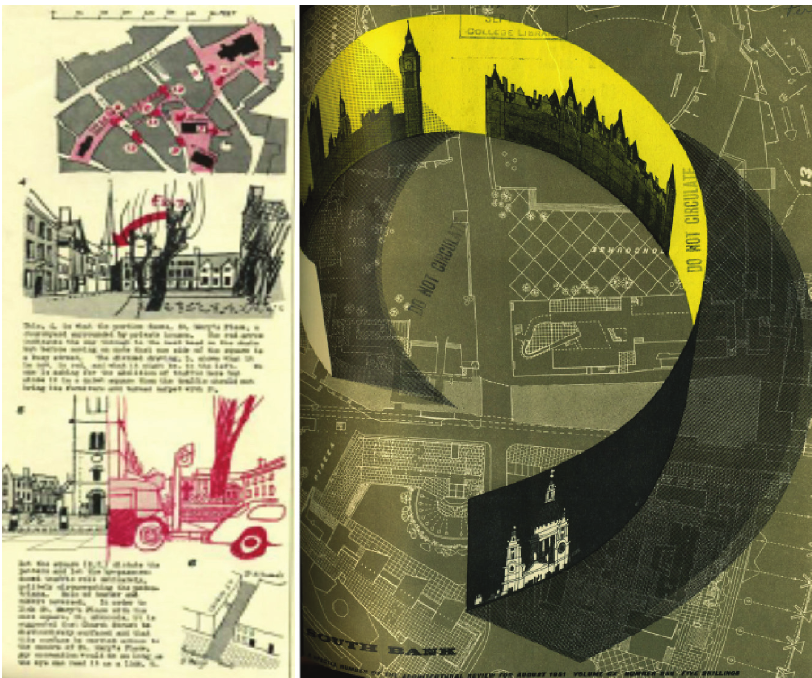
Figure 3. Gordon Cullen, fragment page, from “Midland Experiment: Shrewsbury,” Architectural Review , May 1954 (left); Gordon Cullen and D. Dewar Mills, cover design, Architectural Review, August 1951 (right). Source : The Architectural